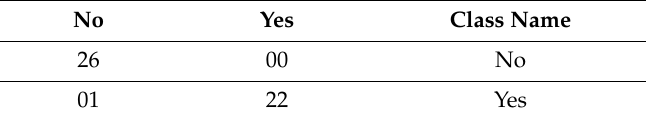
Table 14. Matrix with reduced dimensions for fold 3.